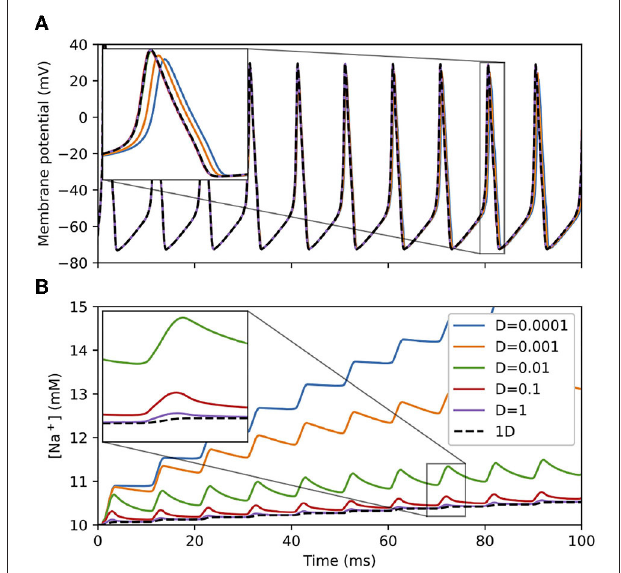
FIGURE 6 | (A) Membrane potential and (B) surface voxel sodium concentration of a 3D cylindrical soma with Hodgkin-Huxley channels and sodium accumulation, 10 µ m in diameter and 10 µ m in length with a constant current injection of 0.1 nA at various diffusion constants D ( µ m 2 /ms). Legend applies to both sub-figures. Insets: magnified views of indicated regions showing differences in 3D results depending on the diffusion constant and convergence to the 1D solution (black dashed line) as the diffusion constant increases.